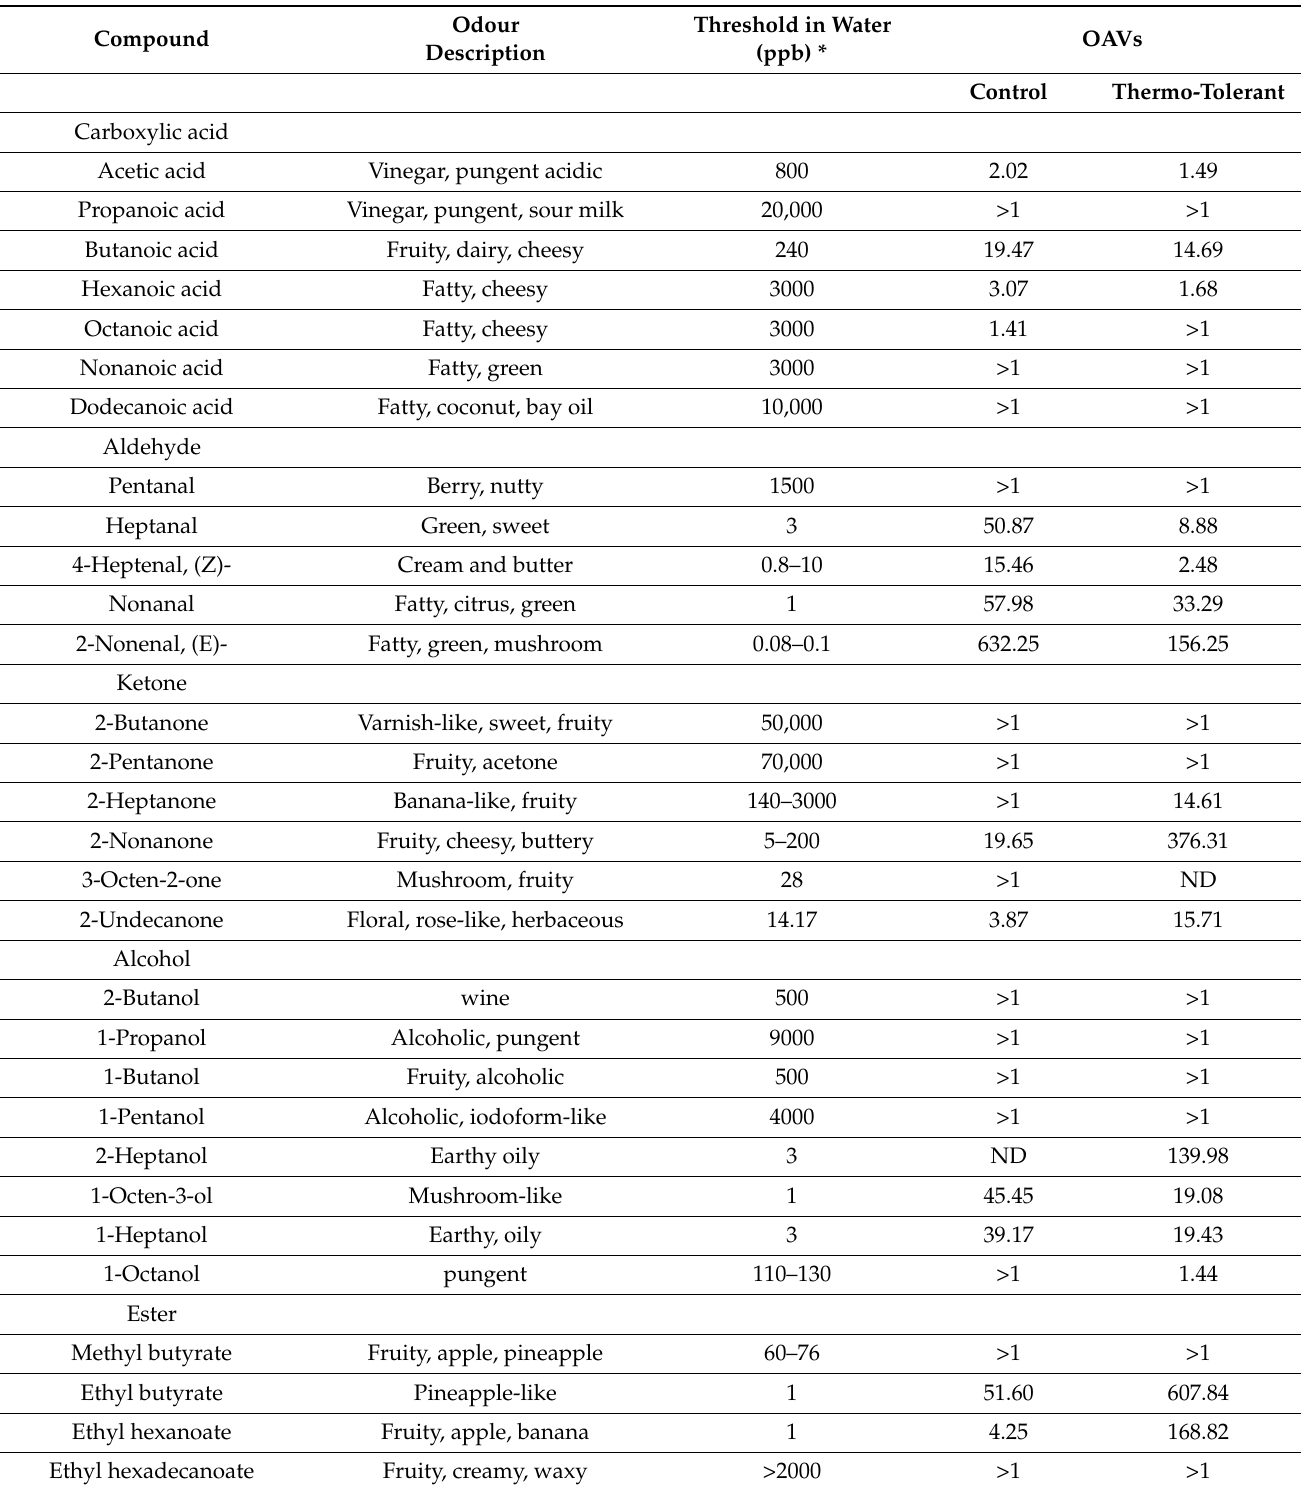
Table 3. Odour descriptors of selected volatile compounds, relative odour activity value (OAV) and odour threshold in water identified in inoculated milk samples are shown. * Odour threshold values in water were adapted from Leffingwell & Associates’ website [28]. Odour descriptions of volatiles were adapted from